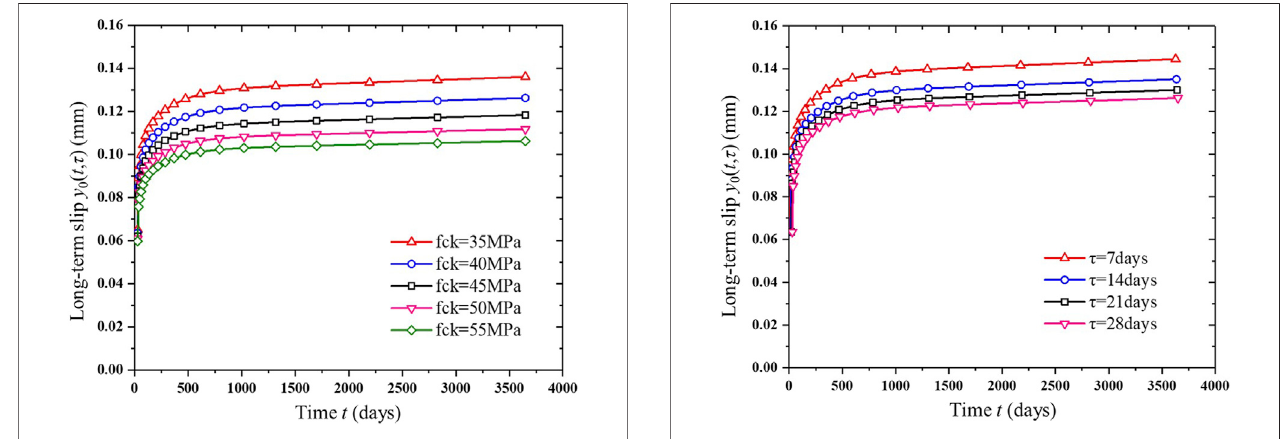
FIGURE 11 | Time dependent relative slip with increasing loading age.